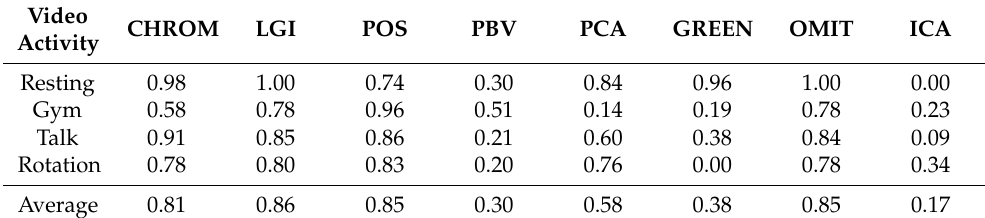
Table 3. Average overall evaluation score for each rPPG method.